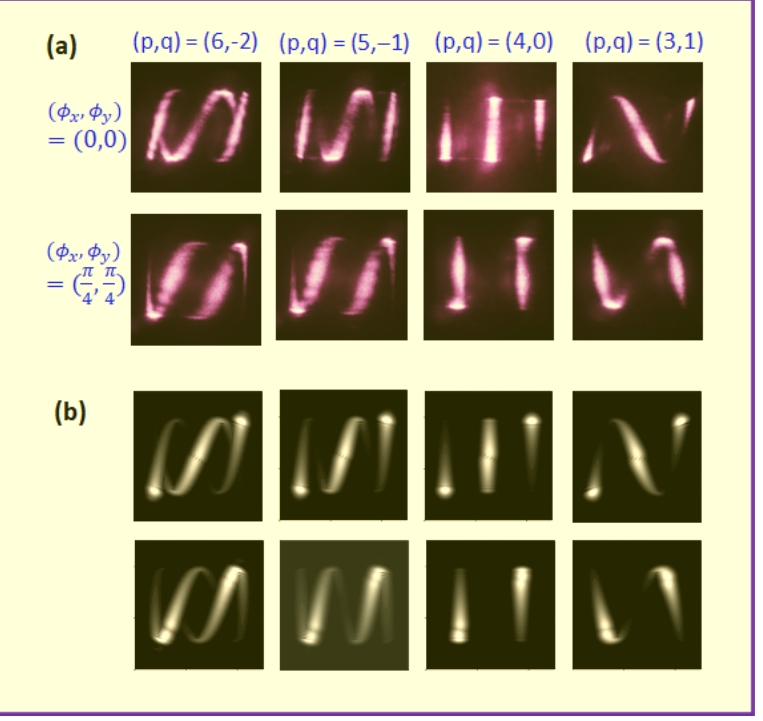
Figure 18. ( a ) Experimental results for the far-field patterns of Lissajous geometric modes generated by using an output coupler with 𝑇 (cid:3042)(cid:3030) = 25% . ( b ) Numerical patterns obtained from Equation (57).